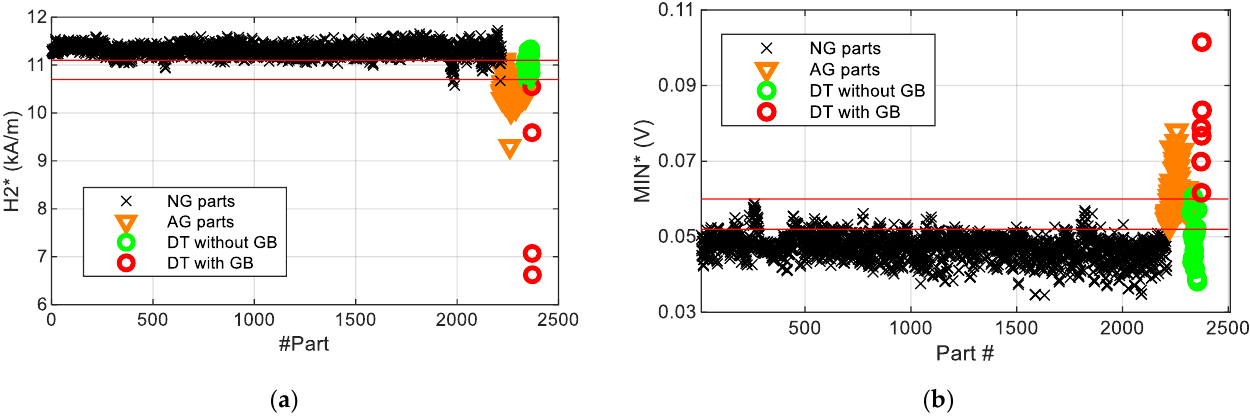
Figure 8. ( a ) The minimum value of the H2 parameter (H2*) and ( b ) the mean value of MIN parameter (MIN*) measured along the ball screw helical path for the whole set of ball screws separated into groups: normally ground parts (“NG parts”), abnormally ground parts (“AG parts”), correct parts (without grinding burn (GB)) verified via destructive testing (DT) (“DT without GB”) and parts with grinding burn (GB) verified via destructive testing (DT) (“DT with GB”). Standard deviation value of H2* is 210 A/m and of MIN* is 0.6 mV.